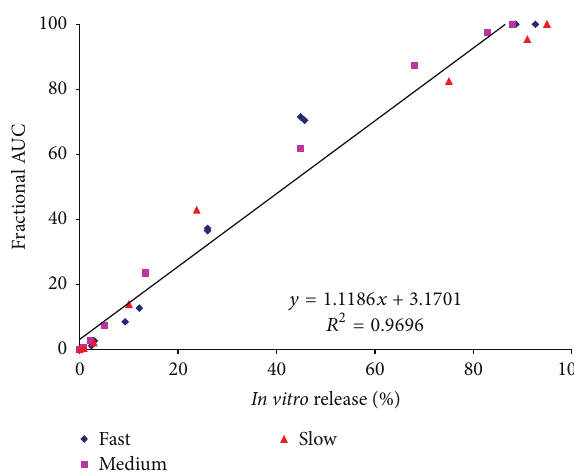
Figure 10: Pooled IVIVC for Olanzapine PLGA microsphere for- mulations using fractional AUC (Level